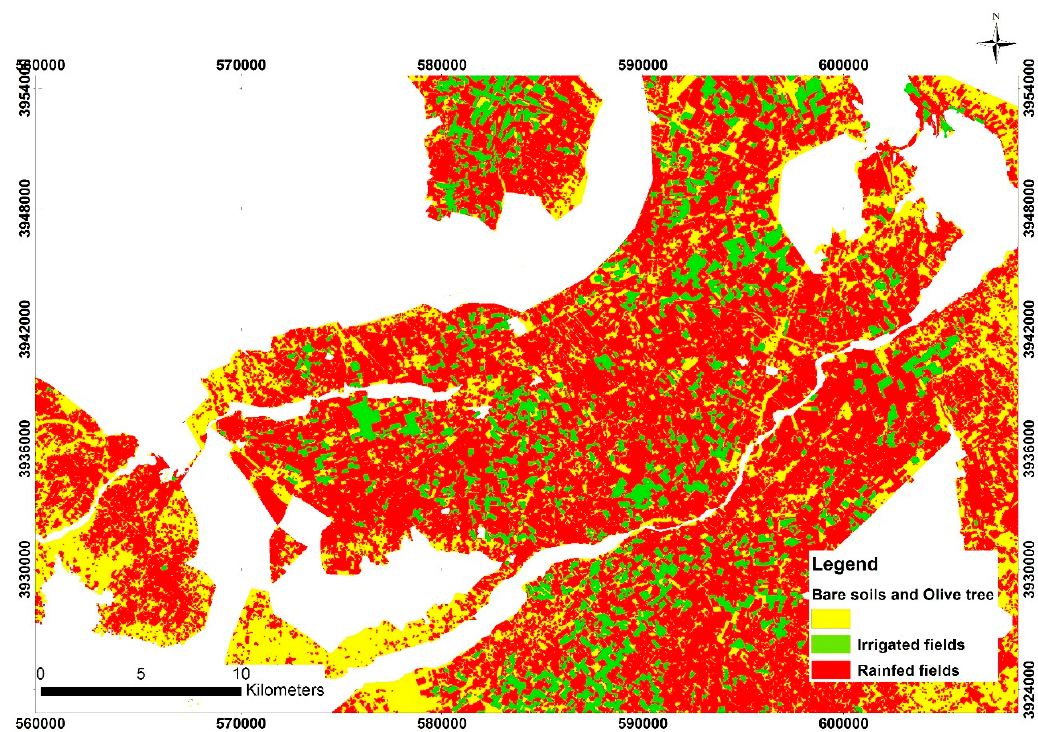
Figure 12. Classification of irrigated and rainfed areas using both soil moisture and NDVI parameters.